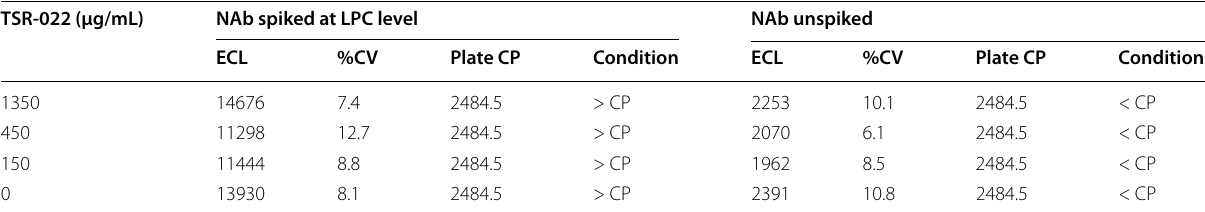
CP cut point, %CV coefficient of variation, ECL electrochemiluminescence readout, LPC low-positive control, NAb neutralizing